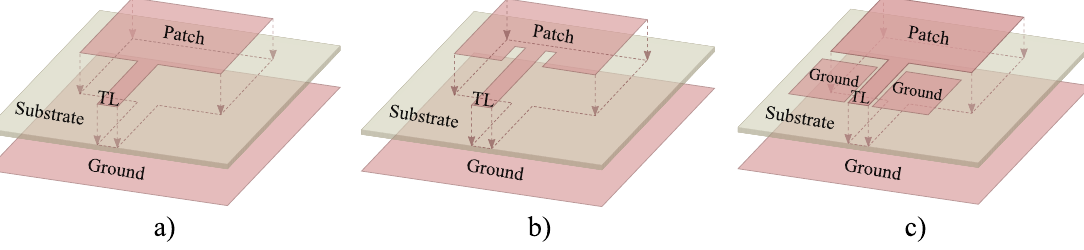
Figure 2. ( a ) Microstrip line fed. ( b ) Microstrip line inset fed. ( c ) Coplanar waveguide fed